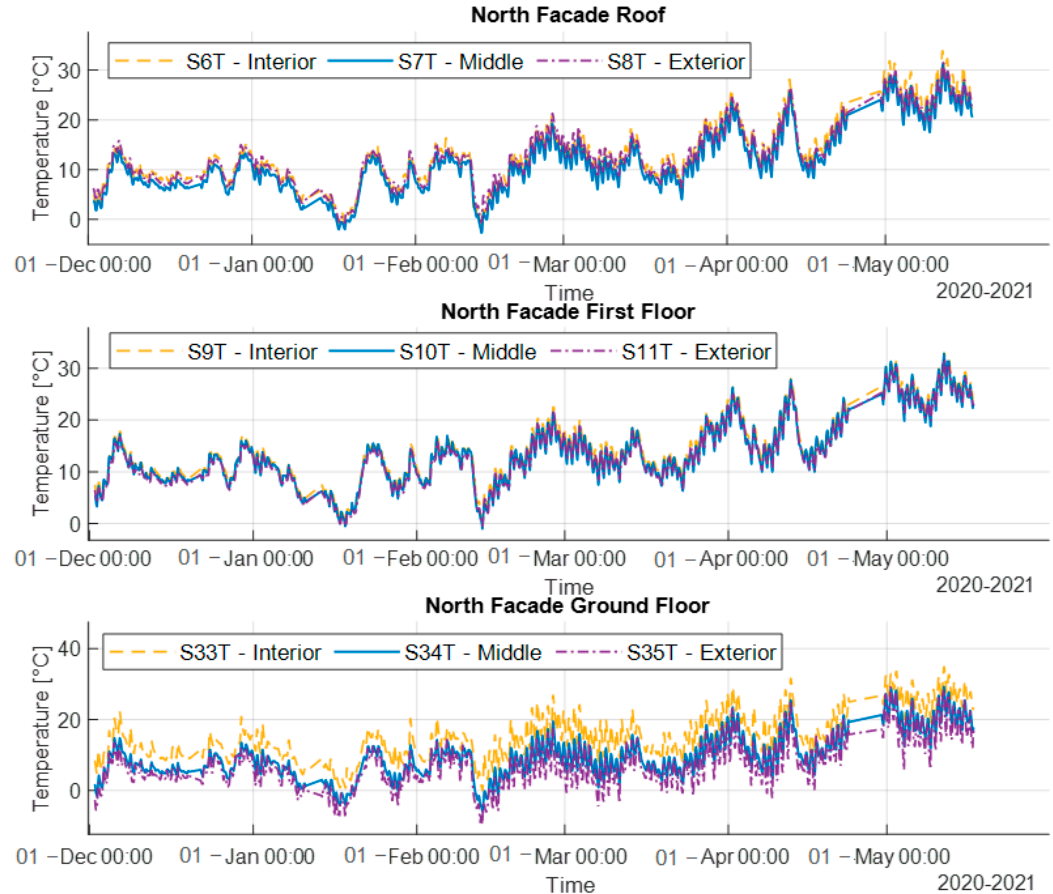
Figure 16. Temperature data provided by the sensors for the northern side of the building: roof (above), first floor façade (middle), and ground floor façade (below).